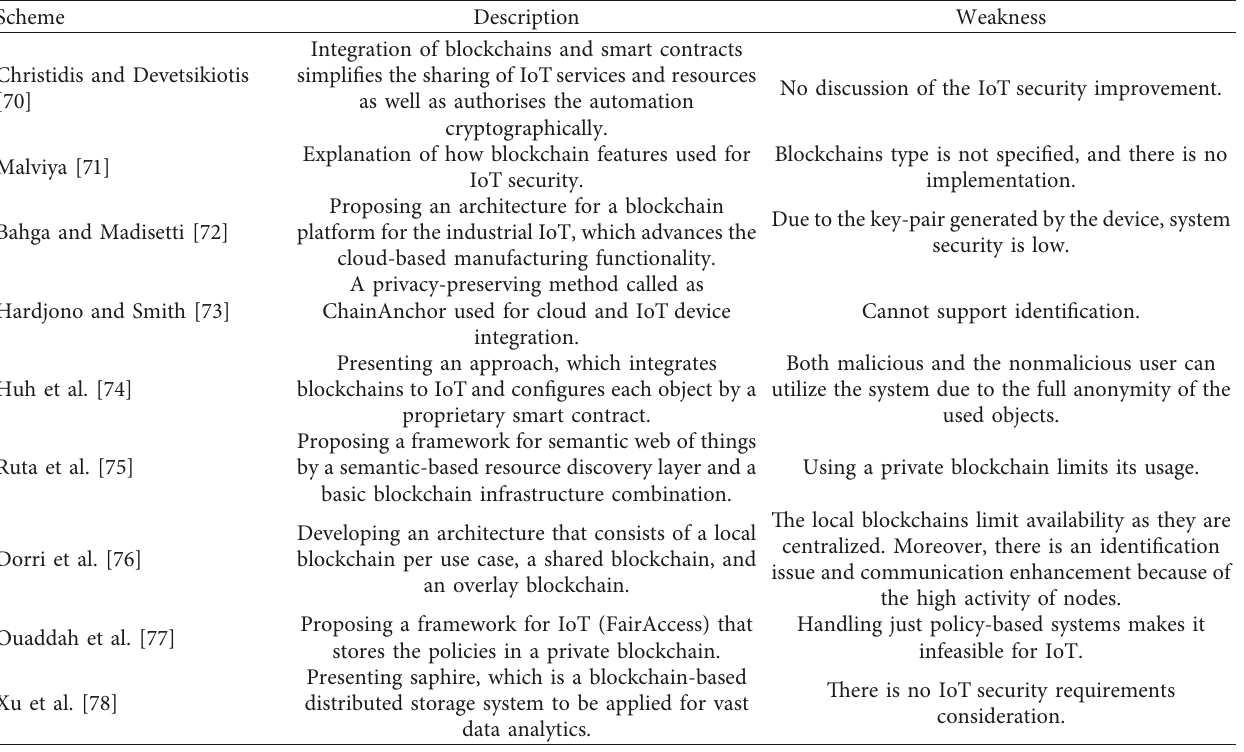
Table 5: Security mechanism based on Bitcoin or